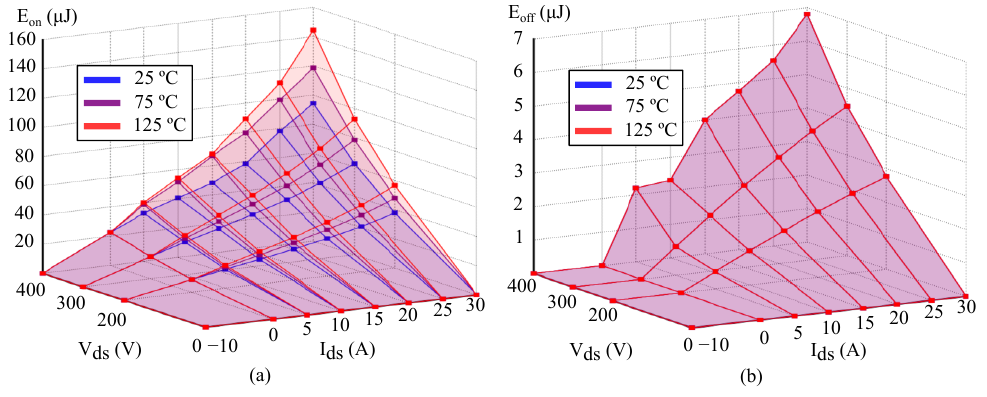
Figure 8. GaN e-HEMTs look-up tables: ( a ) turn-on and ( b ) turn-off losses. Equations allow direct calculation of losses using parameters, such as device voltage, current, junction temperature, gate voltages, and external gate resistances. Moreover, the output of a look-up table can be a variable of an equation. This last operation allows obtaining a more accurate loss value. Some manufacturers provide these equations in the thermal model of their transistors. The manufacturer details that the turn-on losses of the modelled GaN e-HEMTs (GS66508B and GS66508T) are defined as